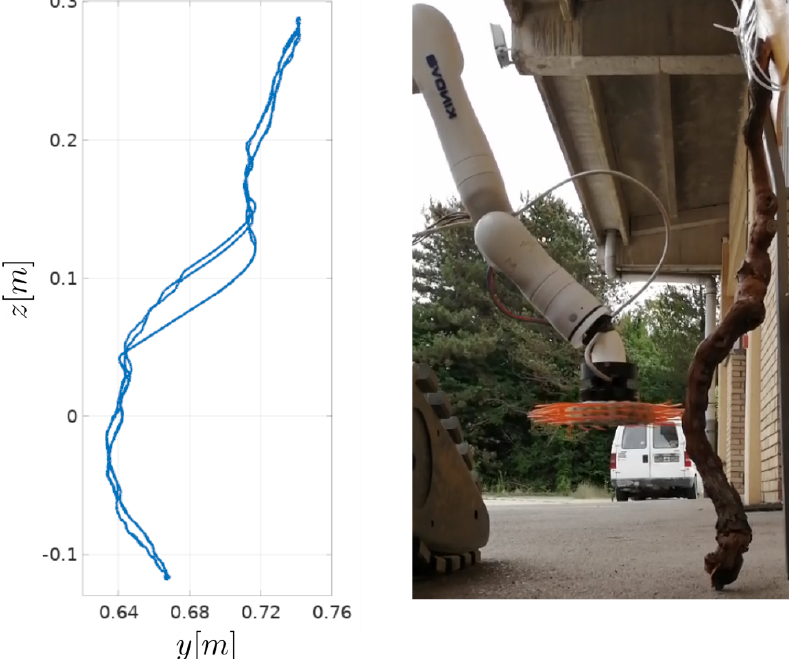
Figure 9. Plant trunk shape following results. The position of the robot arm end-effector in y − z plane is shown on the left, and the trunk shape is shown on the right.